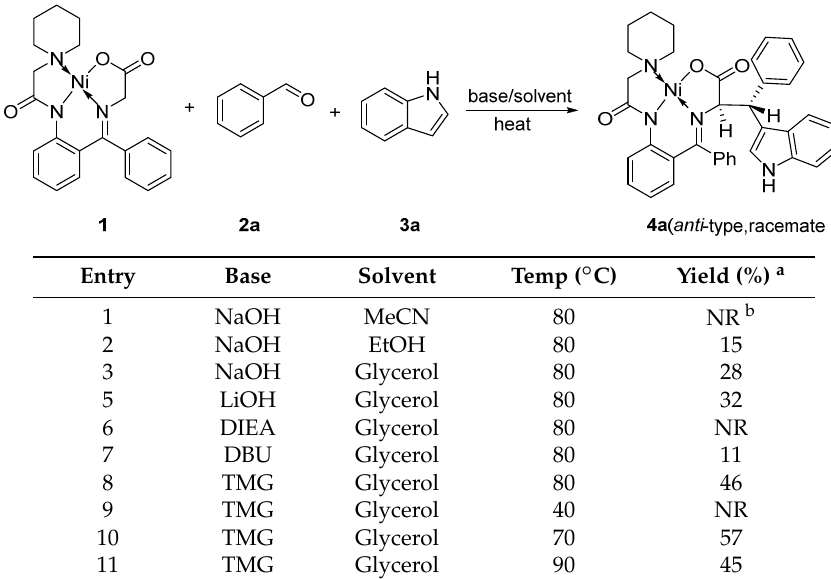
Table 1. Optimization of the reaction conditions.